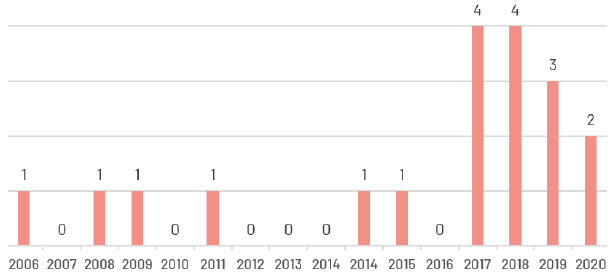
Figure 5. Number of classification published per year